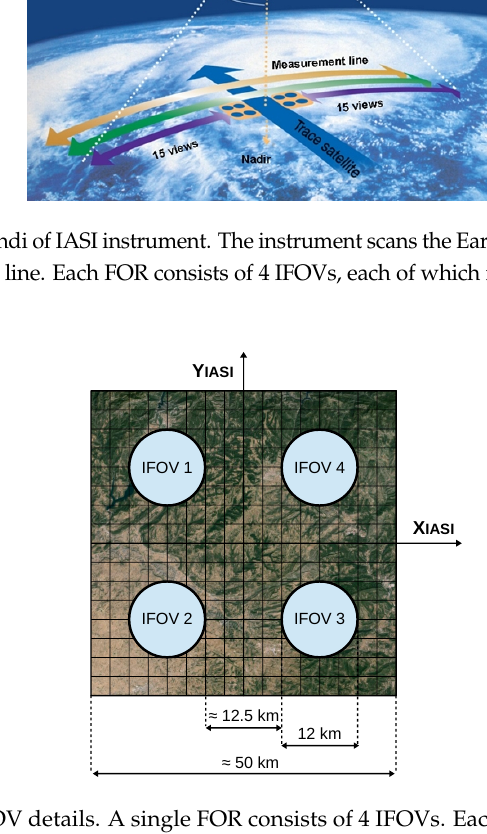
Figure 3. FOR and IFOV details. A single FOR consists of 4 IFOVs. Each IFOV spreads 12 km of the Earth’s surface and is separated from its neighboring IFOVs by 12.5 km. Each FOR corresponds to, approximately, 50 km of the Earth’s